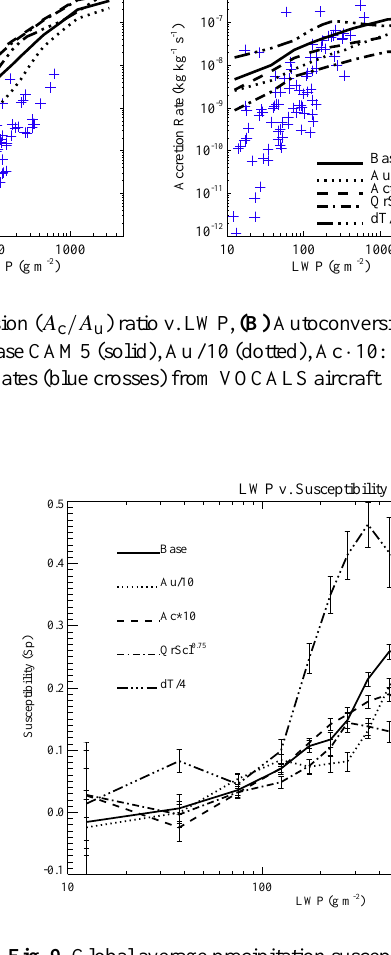
Fig. 9. Global average precipitation susceptibility ( S p ) as defined in the text. Simulations are described in Table 2. Base CAM5 (solid), Au/10 (dotted), Ac · 10: (dashed), QrScl 0 . 75 (Dot Dashed) and d T/ 4 (triple